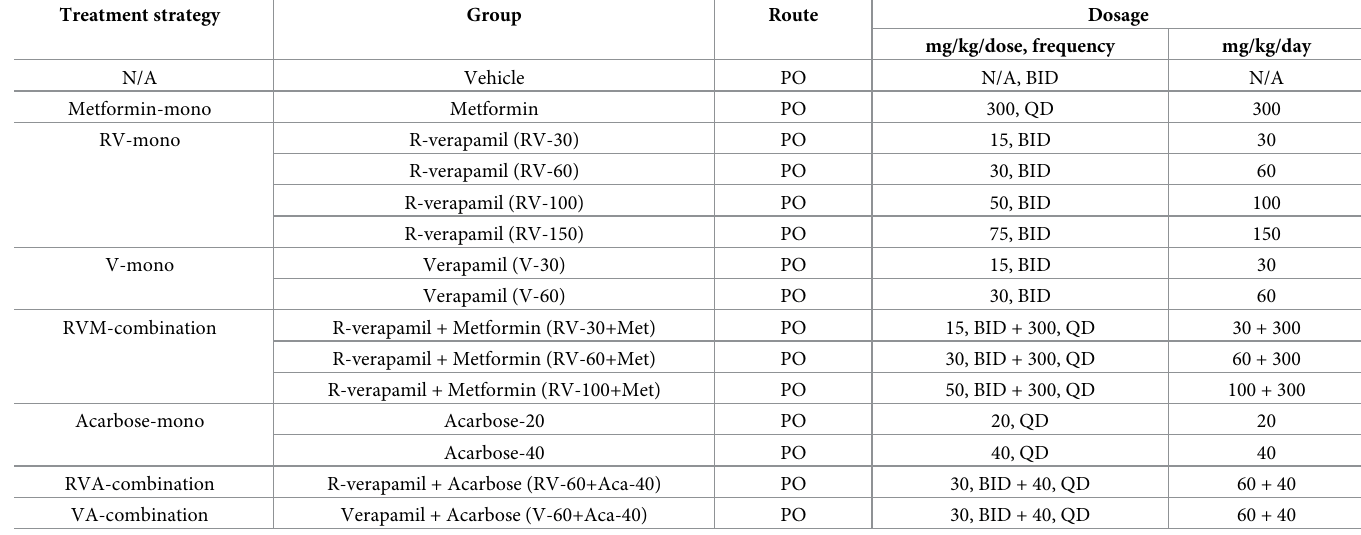
Table 2. Dosages and dosing frequencies of drugs used in T2DM mouse model study. Treatment